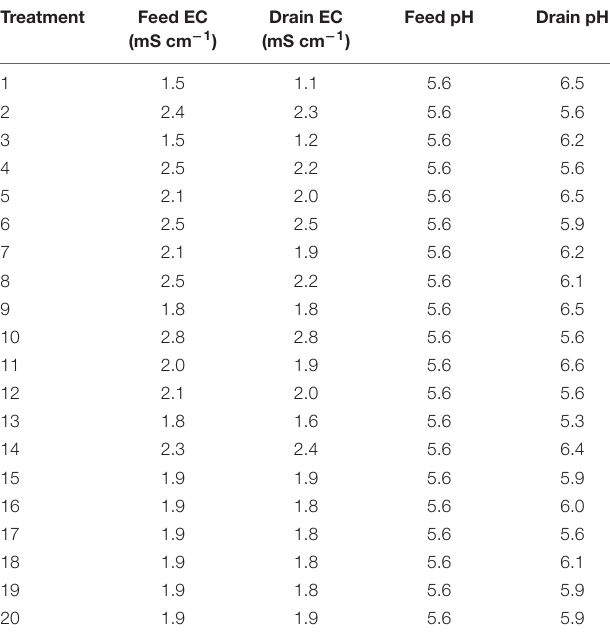
TABLE 5 | Electrical conductivity (EC) and pH of feed and drain nutrient